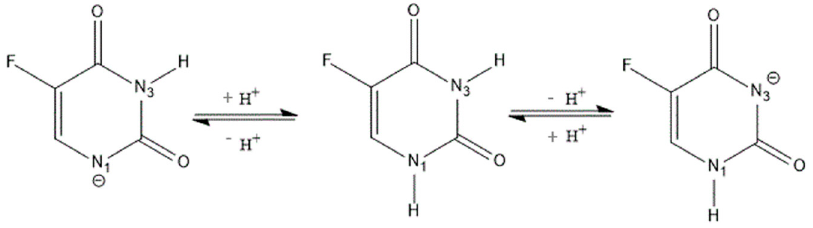
Figure 2. The N1 and N3 deprotonation sites of 5-fluorouracil.